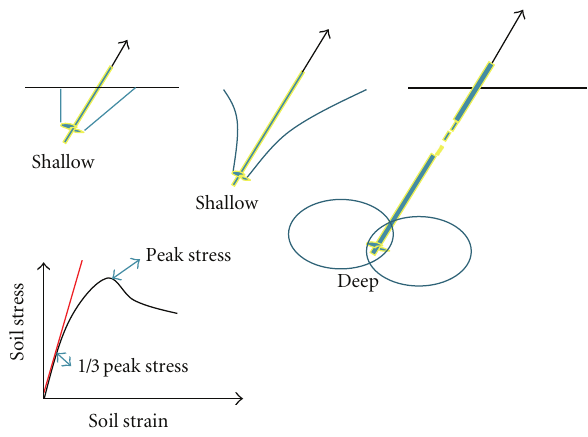
Figure 1: Basic assumption behind elasticity-based design (modi- fied from Matthews [12]).